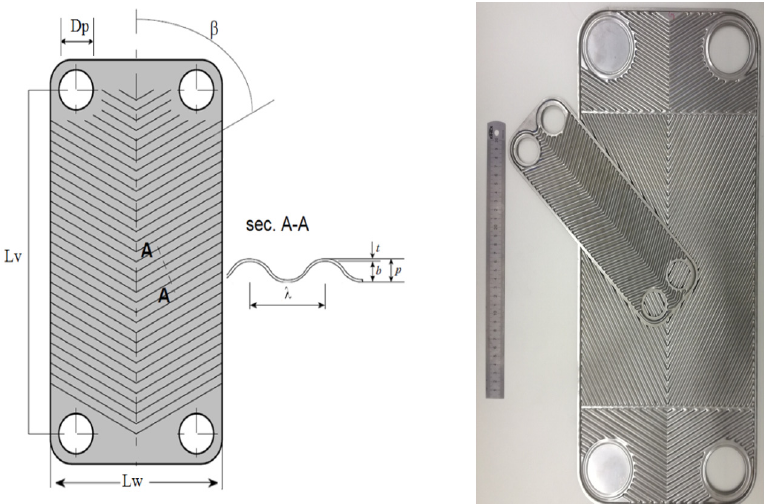
Figure 1. System diagram including the combined plate heat exchanger.